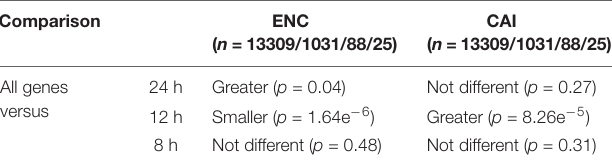
TABLE 3 | Results of Wilcoxon Tests for ENC/CAI distributions of 24, 12, and 8 h oscillating gene subsets against the whole mouse genome; “ n ” represent s the size of each